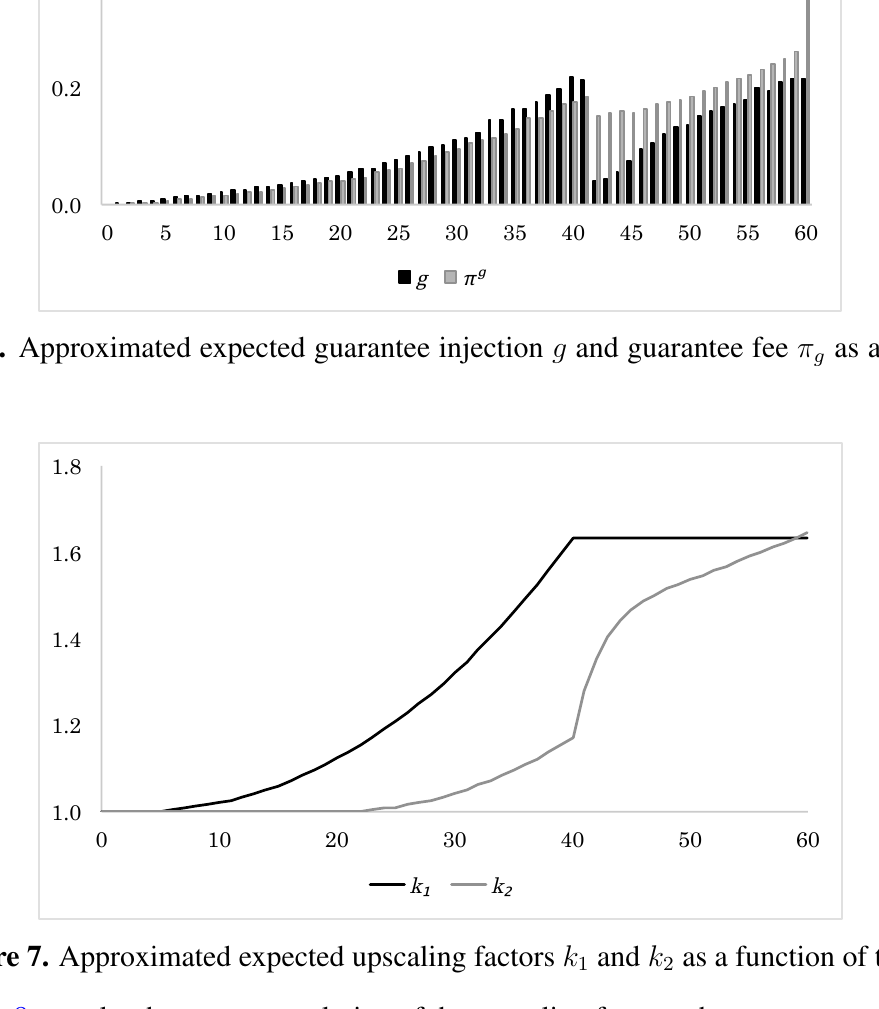
and k as a function of 1 2